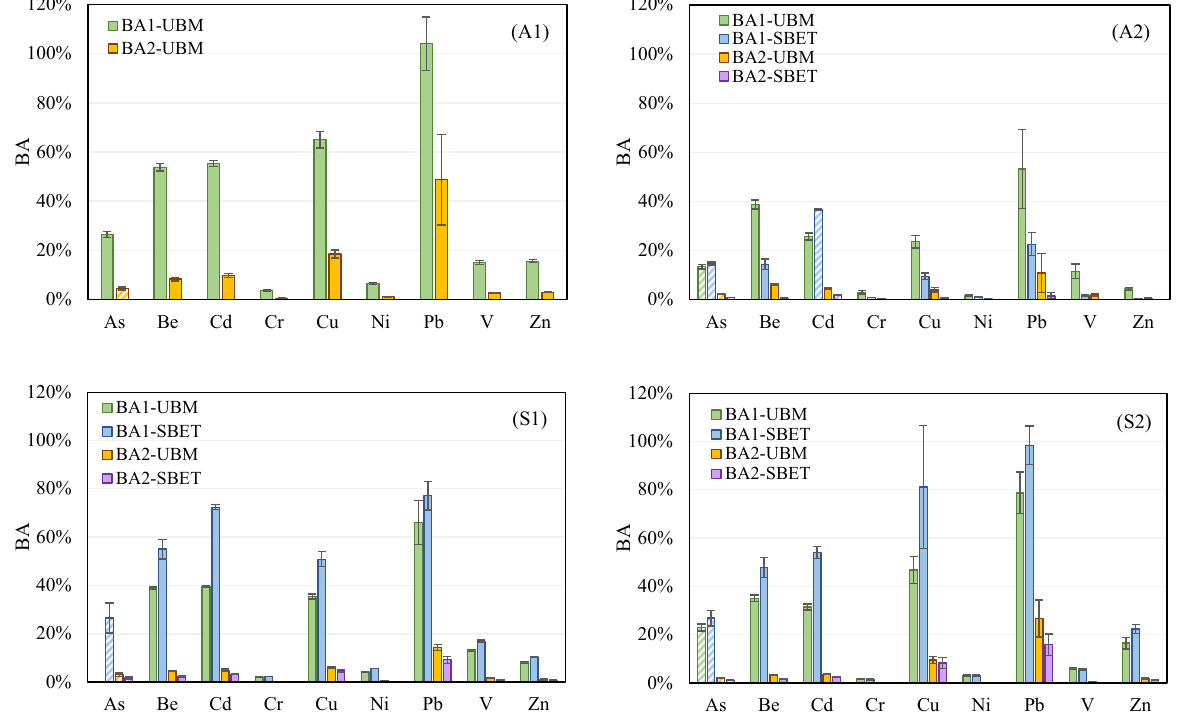
Figure 4. Bioaccessibility of metals and metalloids contained in samples A1 , A2 , S1 , and S2 estimated adopting Equations (9) and (10). Striped bars represent values obtained from bioaccessible concentration lower than the limit of quantification .